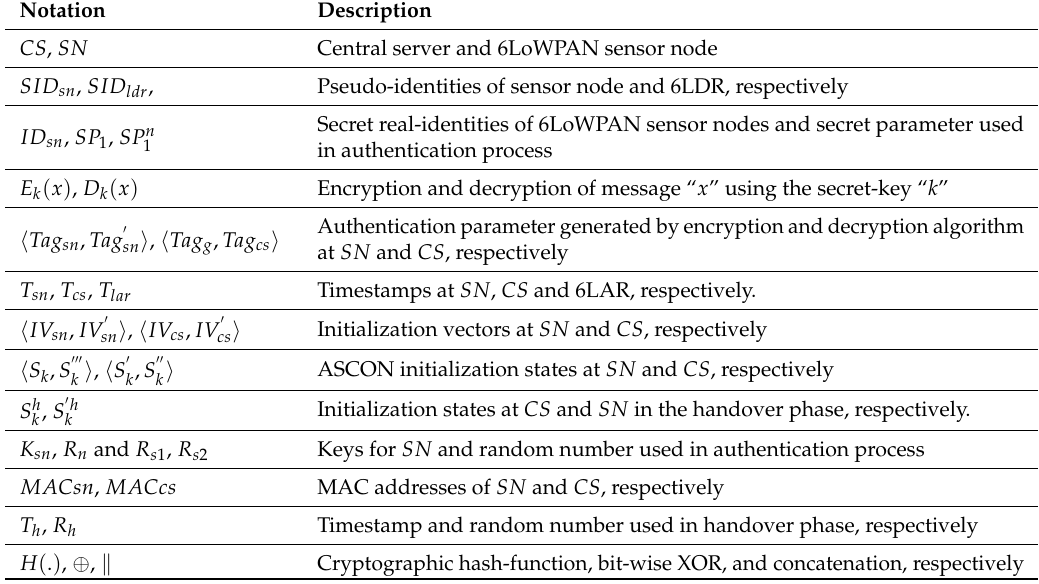
Table 1. List of